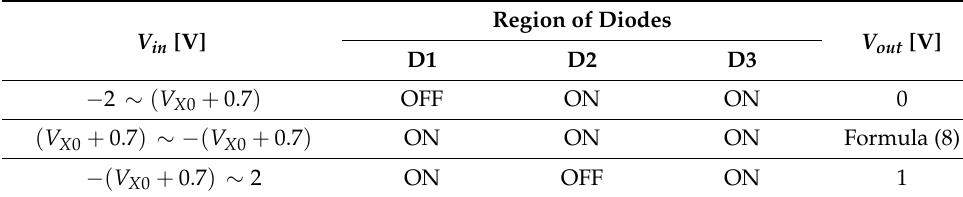
Table 1. The three phases of the region for diodes.